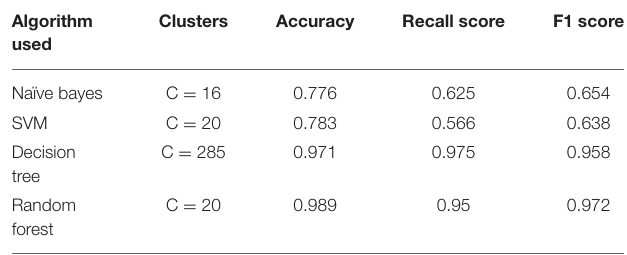
TABLE 3 | Evaluation attributes results for different models (Frankfurt Germany).